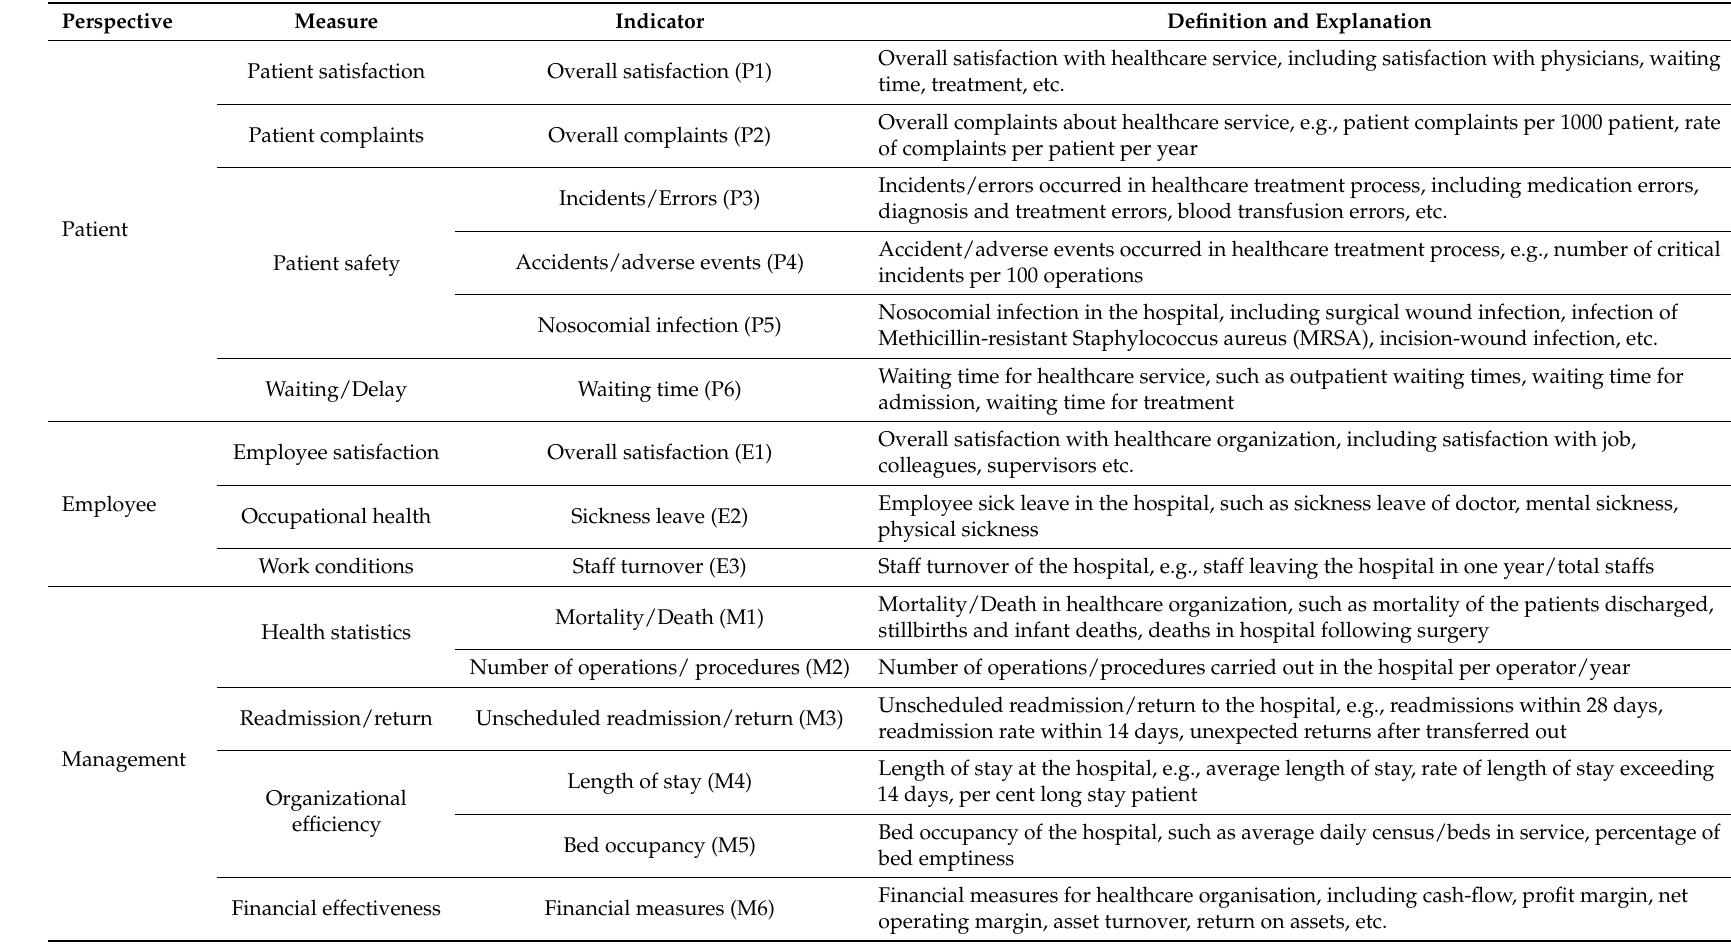
Table 1. Performance indicators frequently used in previous